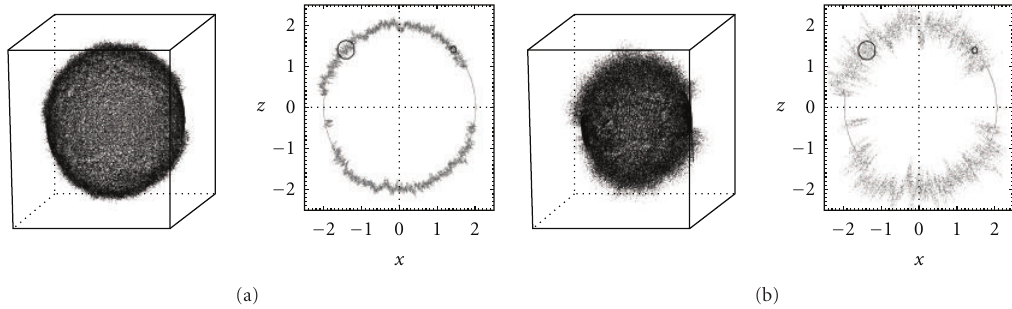
Figure 1: WMAP 3-year data after application of the transformation into a three-dimensional point distribution. In the first and the third plots, the full set of points is presented, while the second and fourth show an x , z -projection of only the points with | y | < 0 . 05. Two di ff erent adjustment parameters were used, a = 0 . 075 (a) and a = 0 . 225 (b). The black circles represent the scaling ranges r = 0 . 075 and r = 0 . 225. Figure taken from